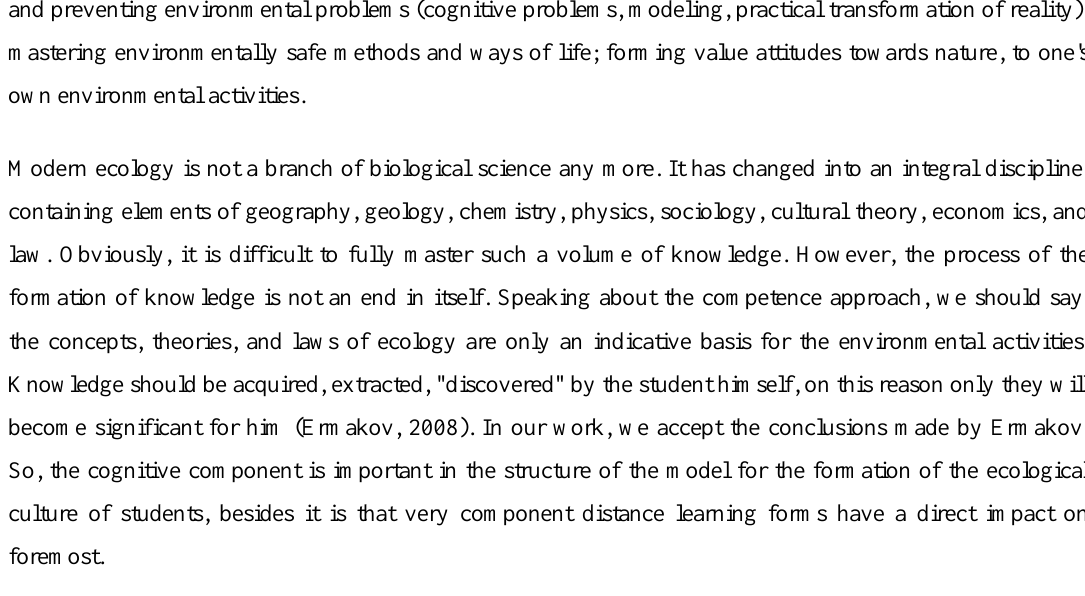
Table 1. Evaluation of the effectiveness of remote forms of obtaining information and participating in environmental